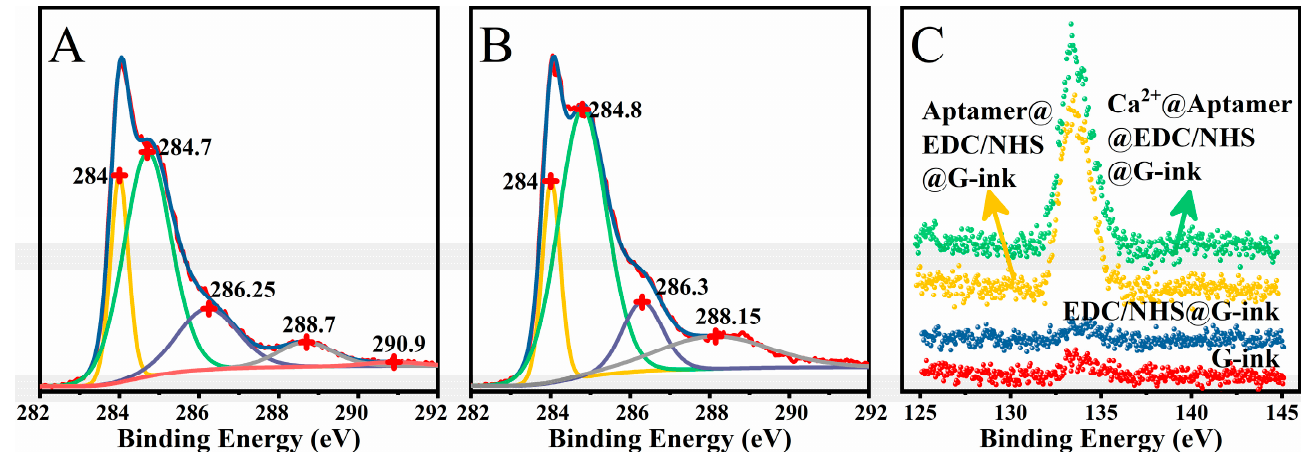
Figure 2. XPS Characterization: ( A ) the deconvoluted C1s spectra of G-ink film; ( B ) the deconvo- luted C1s spectra of EDC/NHS treated G-ink (EDC/NHS@G-ink); ( C ) the P2p spectra of G-ink,